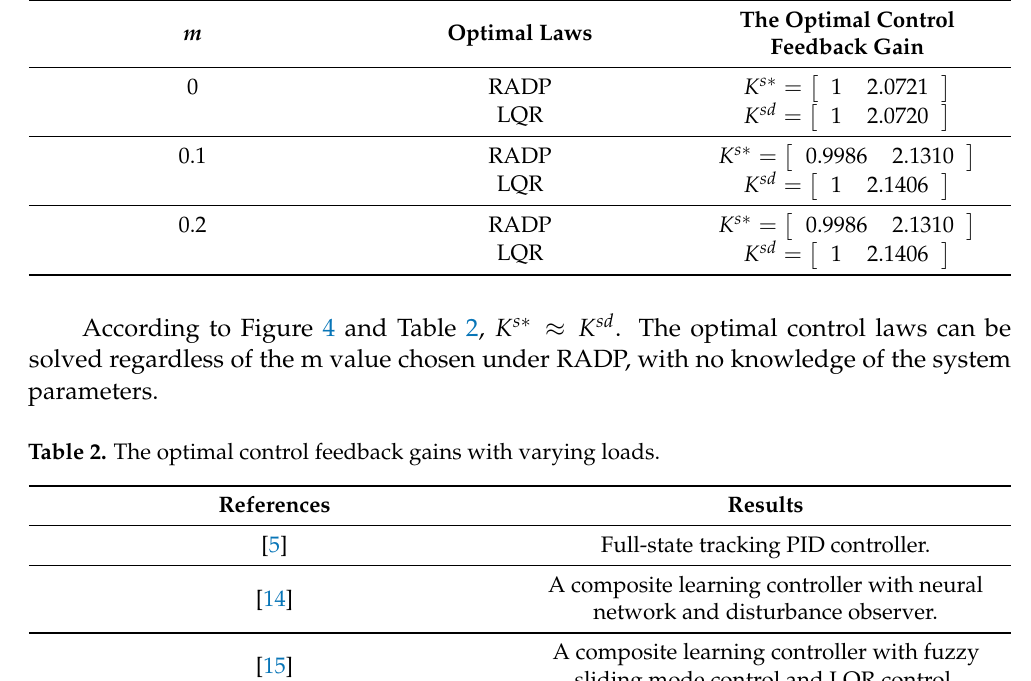
Figure 3. q 2 ( m ) mode position curve of the original system and the fast subsystem. Table 1. The optimal control feedback gains with varying loads.